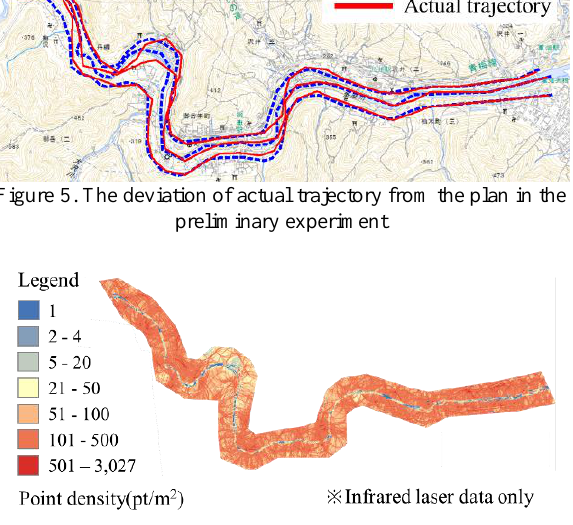
Figure 6. Point density of the preliminary experiment